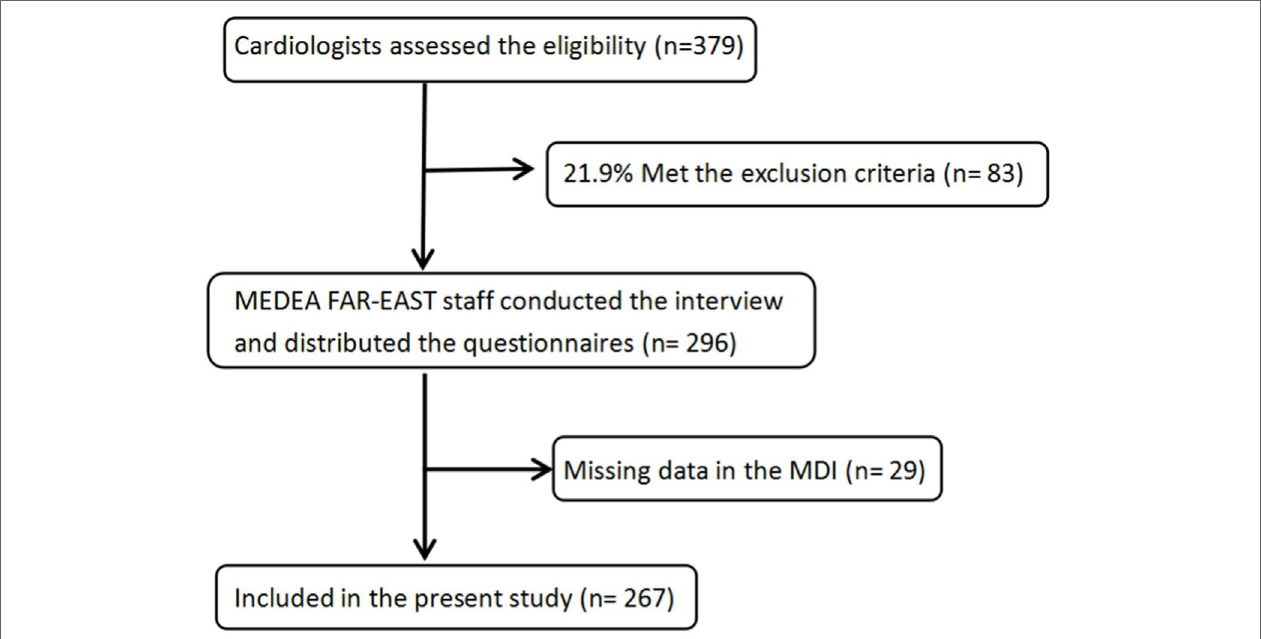
FIGURE 1 | Consort chart of patients in the “Multicenter Delay in Patients Experiencing Acute Myocardial Infarction in Shanghai” (MEDEA FAR-EAST)